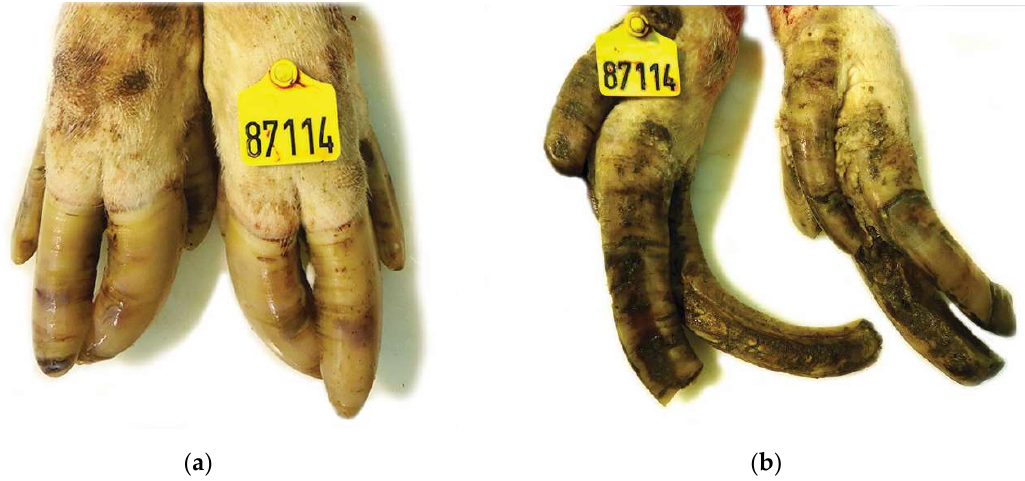
Figure 1. Claw lesions from a culled sow of genetic line A (PIC): ( a ) Mildly overgrown claws of the front limbs showing small cracks bruises throughout the wall hoof; ( b ) Severely overgrown and deformed rough claws of the hind limbs with hyperkeratinization, ridges, cracks and erosions near the coronary area. Overgrown dewclaws are also observed.